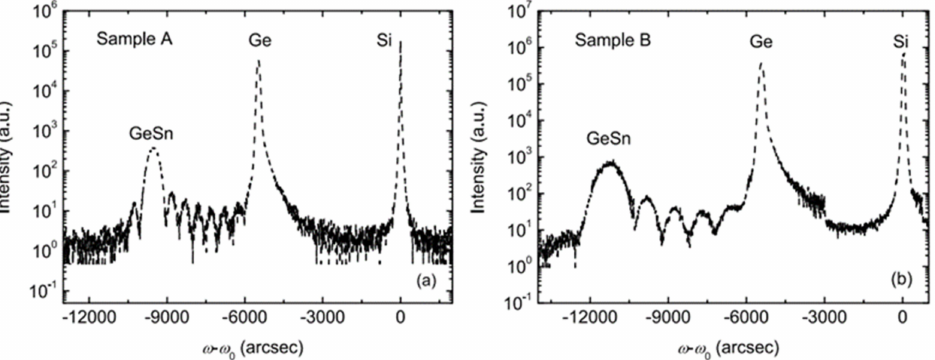
Figure 37. HR–XRD curves for GeSn samples with ( a ) 12% and ( b ) 15% Sn incorporation. Reproduced with permission from [217], IEEE,